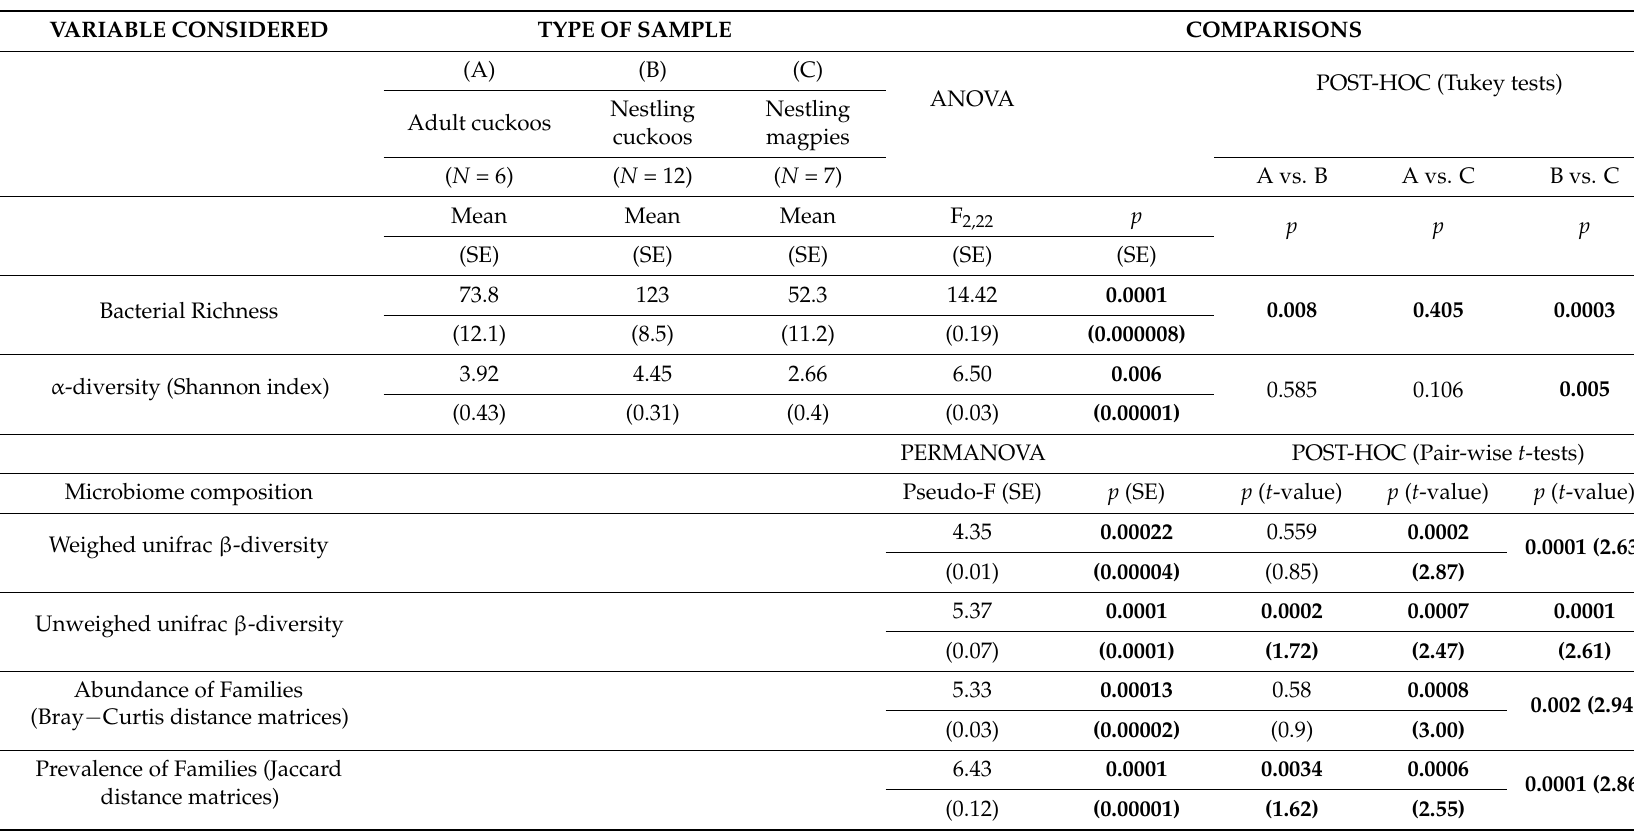
Table 1. Comparisons of gut microbiome of magpie and great spotted cuckoo nestlings and of great spotted cuckoo adults in terms of bacterial richness, α -diversity, composition (weighed and unweighed unifrac β -diversity) and abundance and prevalence of bacterial